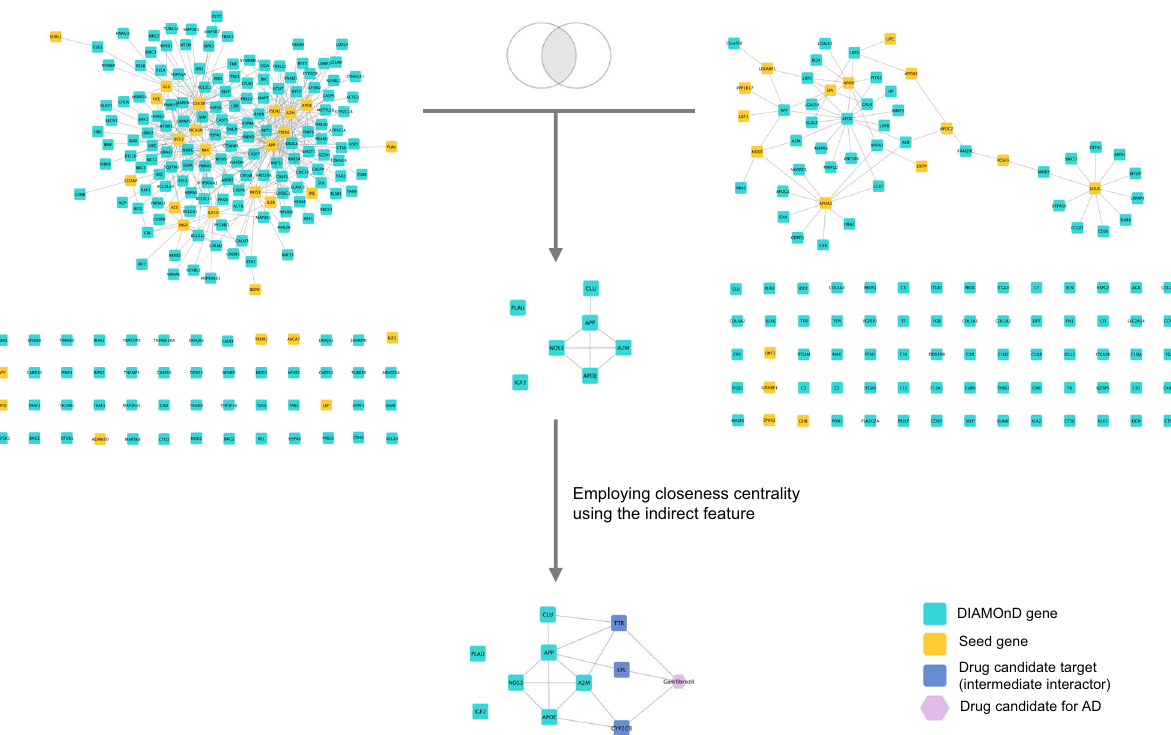
Fig. 6 Gem fi brozil indirectly targets the intersection of disease modules. The AD and hyperlipidemia disease modules (top left and top right, respectively) derived by DIAMOnD using the corresponding disease-associated genes (orange nodes). The intersection of the disease modules is shown in the middle. Gem fi brozil indirectly targets the intersection through TTR, CYP2C8, and LPL (bottom). To allow better visualisation, subsets of actual networks corresponding to the disease modules are shown